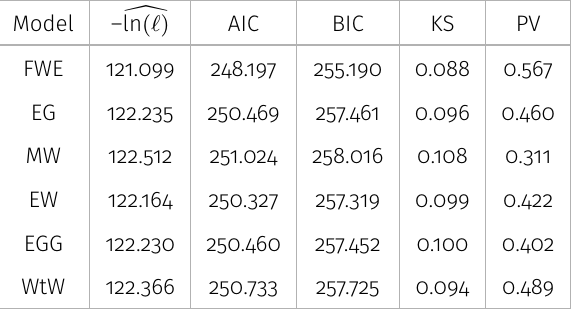
Table IV. The log-likelihood, AIC, BIC, KS and p-values for the fitted distributions for failure times data.